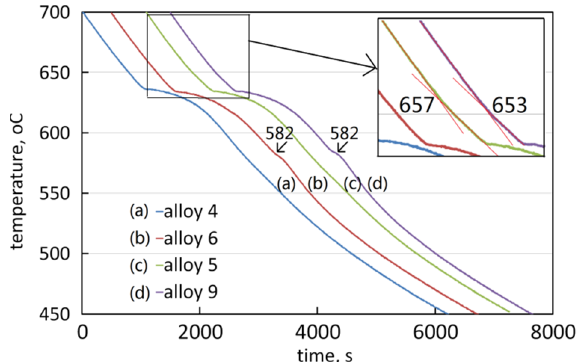
Figure 8. The cooling curves of the alloys.